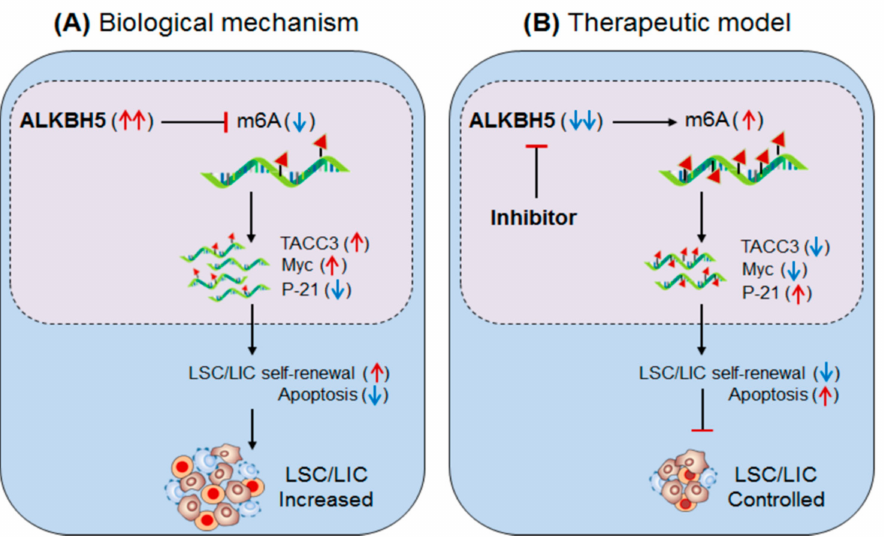
Figure 4. Therapeutic model targeting intracellular m6A-eraser protein ‘ALKBH5 (cid:48) in controlling AML). ( A ) Biological mechanism: The m6A-demethylase ‘ALKBH5 (cid:48) is aberrantly expressed in AML, especially in leukaemia stem/initiating cells (LSC/LIC) and facilitates its progression, indicating its requirement for development, self-renewal, maintenance and propagation. Biologically, the enhanced ALKBH5 in disease-state increases the expression of TACC3 gene by m6A-mediated mech- anism, resulting in increased self-renewal capacity and thereby increased progression of LSC/LICs. ( B ) Therapeutic model: Anti-ALKBH5 therapy: The selective inhibition of ALKBH5 decreases m6A methylation-mediated expression of TACC3 gene resulting in decreased self-renewal and increased apoptosis is well-efficient to control AML subsets.